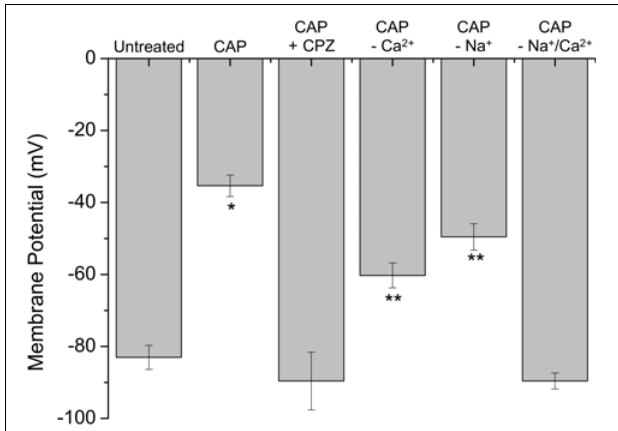
FIGURE 5 | TRPV1 expression induces plasma membrane depolarization in response to CAP. Membrane potential measured by the change in DiBAC 4 (3) fluorescence intensity in st-TRPV1 HeLa cells exposed to 10 µ M CAP for 30 min, in the presence or absence of 10 µ M CPZ, Ca 2 + -free condition, or Na + -free condition. Data are shown as mean ± SEM ( n = 5). ∗ p < 0.01 and ∗∗ p <